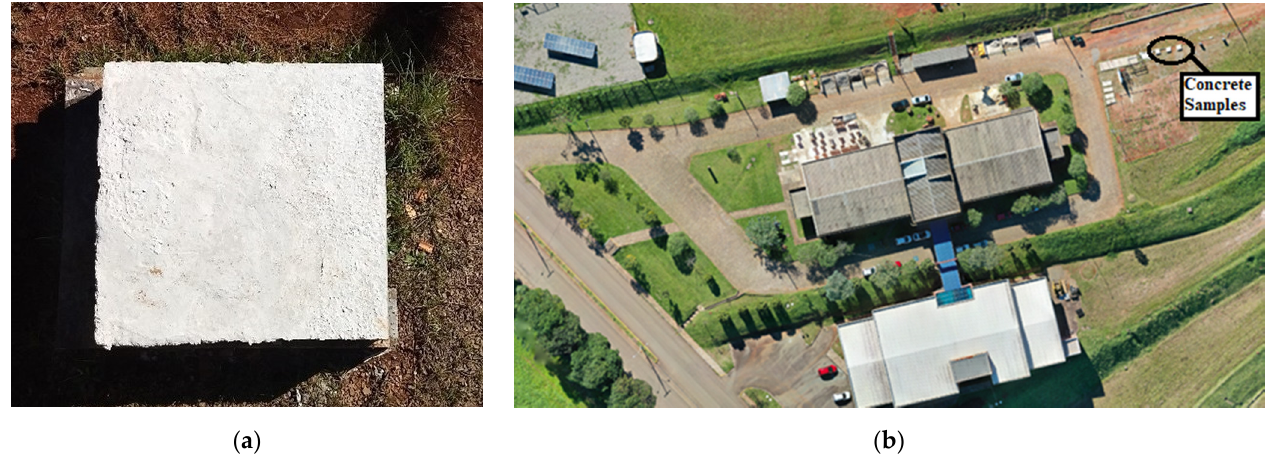
Figure 2. Experiment details: ( a ) Concrete sample after curing; ( b ) location of the samples in the university site.